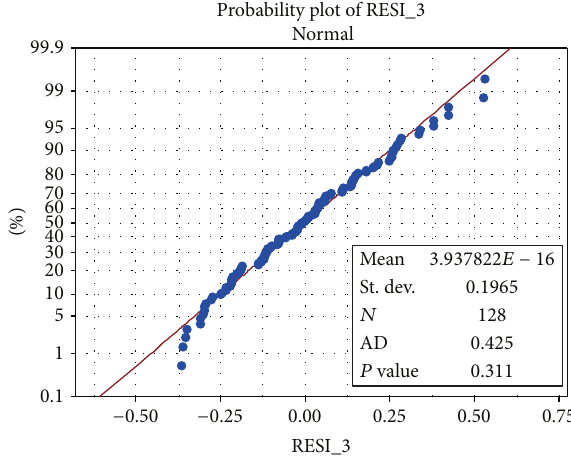
Figure 12: Anderson-Darling normality test results for 𝑅 𝑎